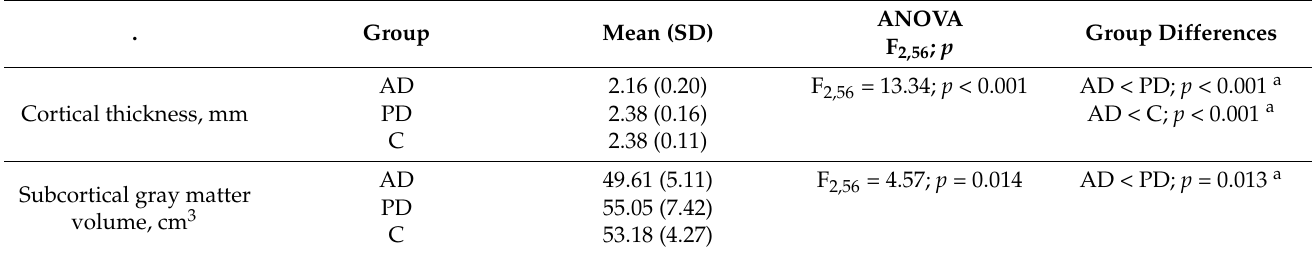
Table 2. Differences in global gray matter morphometric measures.